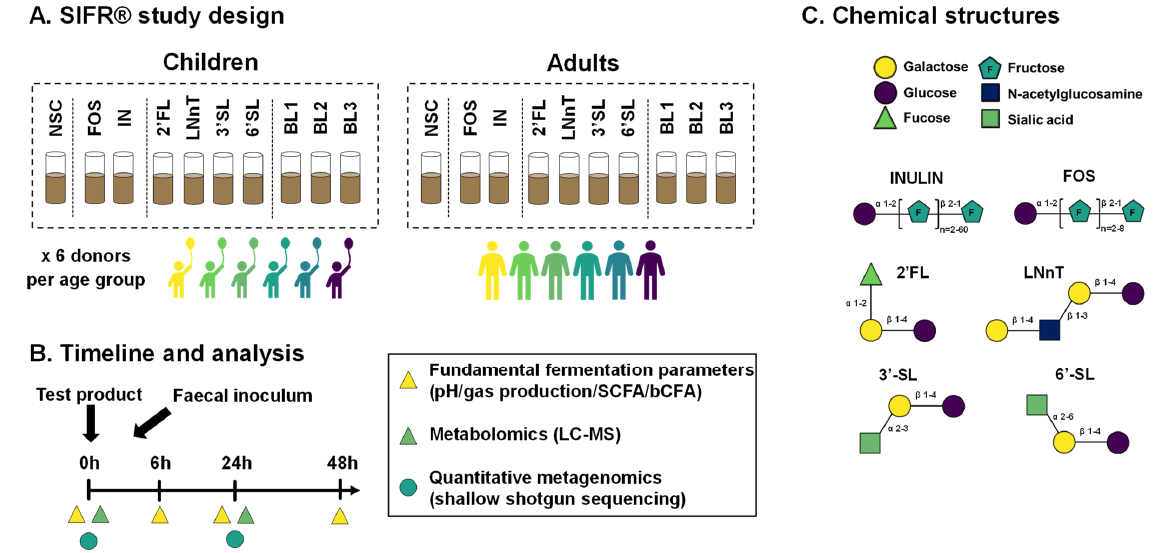
Figure 1. Experimental design to assess prebiotic effects on the gut microbiota of two age groups (children and adults) ex vivo. ( A ) Reactor design using the ex vivo SIFR ® technology to test the impact of single HMOs (2 ′ FL, LNnT, 3 ′ SL, 6 ′ SL), mixtures thereof (BL1, BL2, BL3) and reference prebiotics (FOS and IN) on the gut microbiota of 6-year-old children and human adults, compared to a no substrate control (NSC). ( B ) Timeline and analysis at di ff erent time points. ( C ) Chemical structure of the test products. 2 ′ FL = 2 ′ Fucosyllactose; LNnT = Lacto-N-neotetraose; 3 ′ SL = 3 ′ Sialyl- lactose; 6 ′ SL = 6 ′ Sialyllactose; BL1/2/3 = HMO Blend 1/2/3; IN = inulin; FOS = fructooligosaccharides; SCFA = short-chain fa tt y acids; bCFA = branched fa tt y acids; LC-MS = Liquid chromatography cou- pled with mass spectrometry.